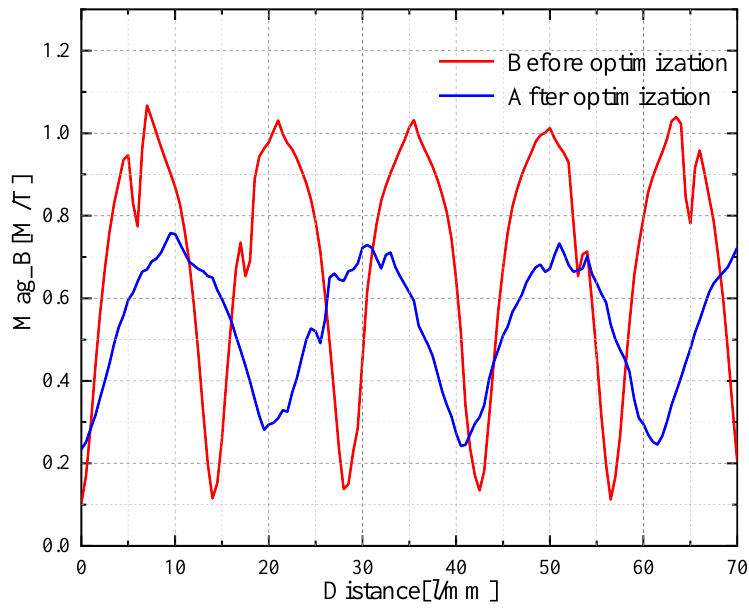
Figure 6. Air-gap flux density.